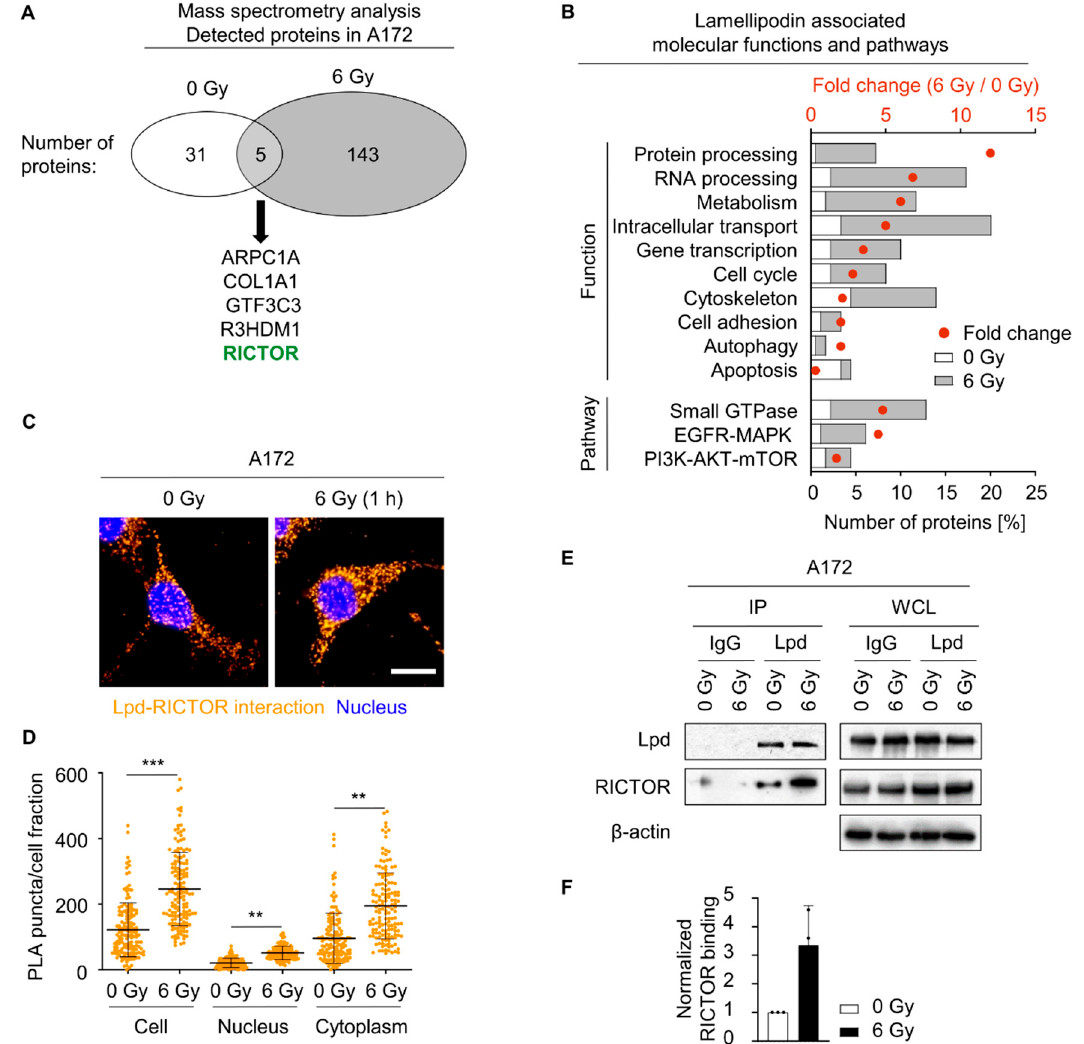
Figure 5. Lamellipodin forms a protein complex with RICTOR. ( A ) Number of detected proteins in unirradiated and 6 Gy-irradiated A172 cells following immunoprecipitation 1 h post-irradiation and mass spectrometry analysis ( n = 2). All identified proteins are provided in Tables S4 and S5. ( B ) Categorization of Lpd interactome into molecular functions and pathways using Reactome and KEGG pathway classification. Comparative analysis of affected pathways upon 0 Gy and 6 Gy was done by calculation of fold change. ( C ) Proximity ligation assay showing interaction of Lpd and RICTOR (orange) in A172 1 h after 0 Gy or 6 Gy X-rays. Scale bar: 20 µ m. ( D ) Quantification of proximity ligation puncta in whole cell, nucleus and cytoplasm from ( C ) using Fiji. Results are presented as mean ± SD ( n = 3, two-sided Student’s t -test, ** p < 0.01, *** p < 0.001). ( E ) Representative immunoprecipitation of Lpd and non-specific control IgG. Immunoblot showing Lpd and RICTOR in copreciptates and whole-cell lysates from unirradiated and irradiated A172 cells. ( F ) Densitometric analyses presenting relative RICTOR binding from ( E ). Fold changes are calculated by normalization to Lpd and 0 Gy according to representative Western blot. Data are shown as mean ± SD ( n = 3). Lpd; Lamellipodin; PLA, proximity ligation assay; IP, immunoprecipitation; WCL, whole cell lysate, IgG, immunoglobulin